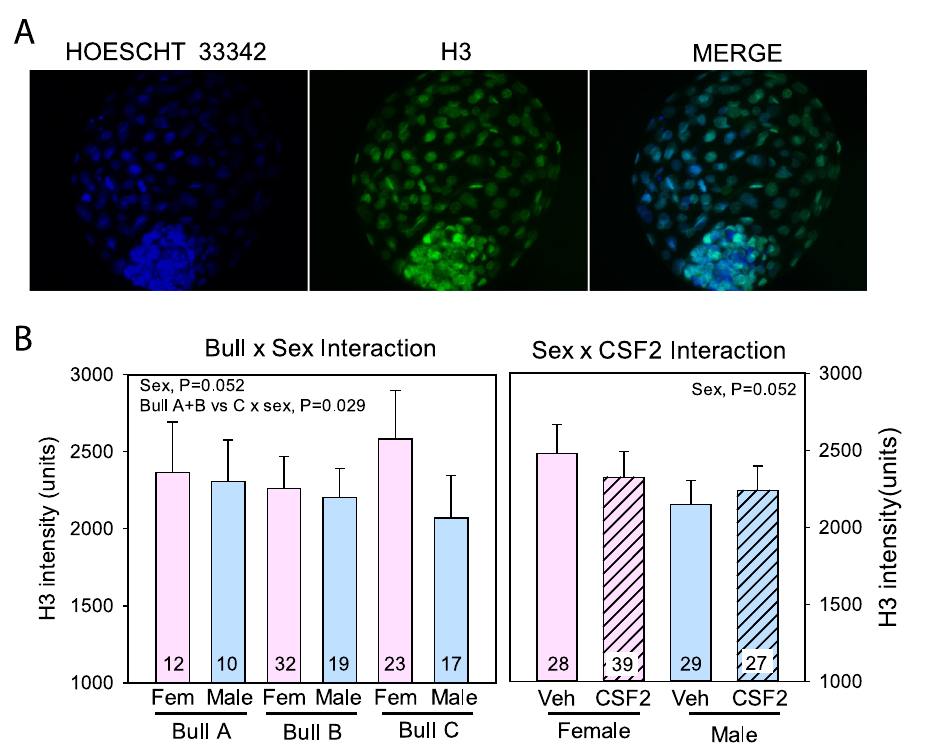
Fig 2. Immunolabeling for histone H3. A. Representative example of labeling of a blastocyst using antibody to H3. B. Least-squares means ± SEM of fluorescent intensity of H3 in nuclei of TE cells as affected by sex, bull, and